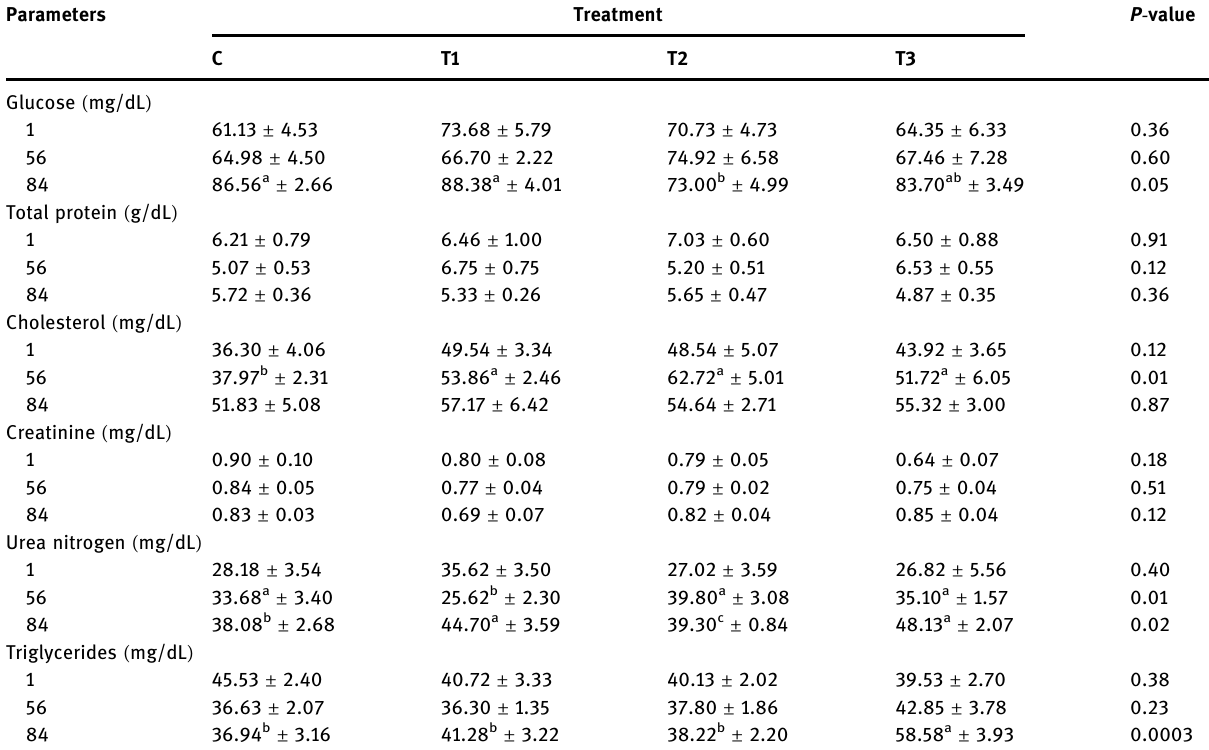
Parameters Treatment